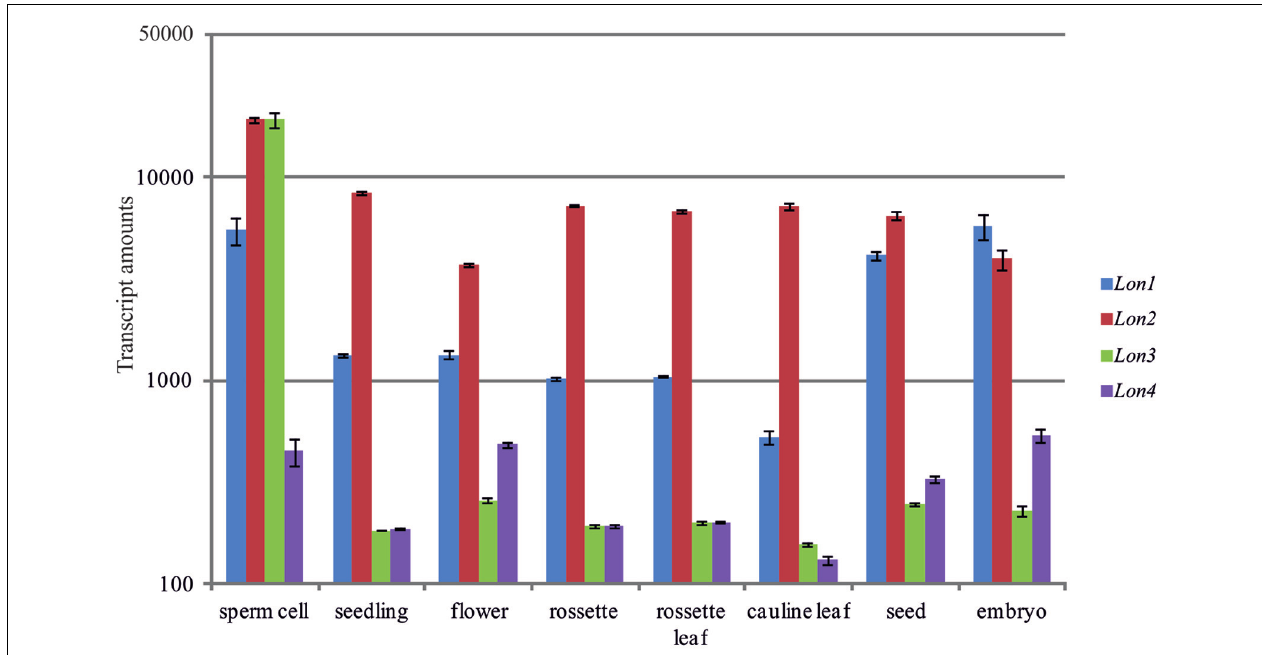
FIGURE 1 | Comparative analysis of the Arabidopsis Lon gene expression profiles in various cell types and tissues. Gene expression data were obtained from the Genevestigator server (Hruz etal., 2008).The vertical axis uses a base 10 logarithmic scale.